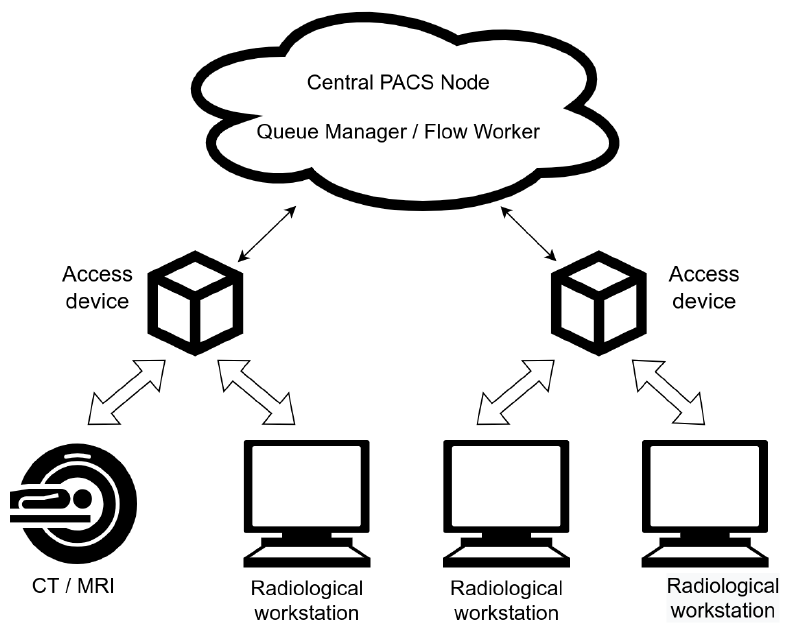
Figure 1. PACS diagram